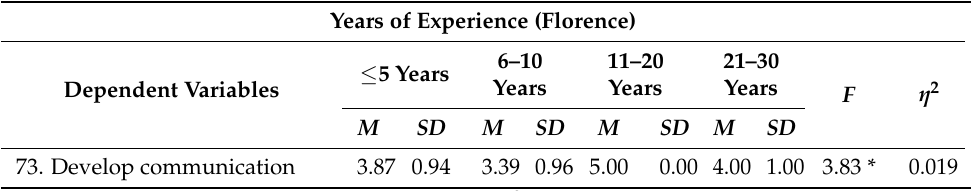
Table 9. Significant differences in the benefits and uses of apps as a function of years of